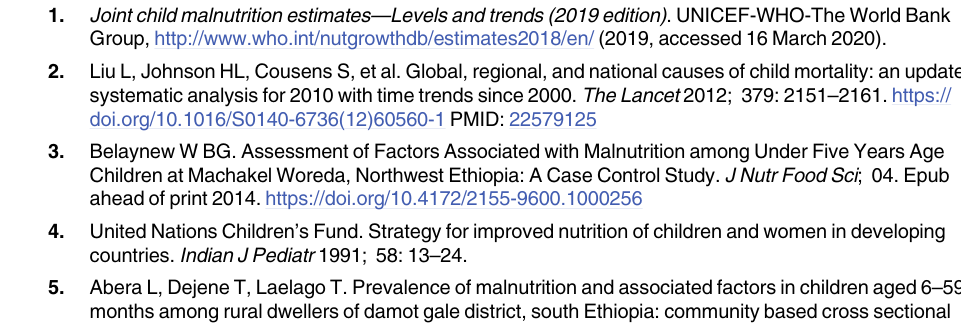
S5 Table. Random effects results from multivariate models. For each indicator, several ran- dom effect mixed models were tested and compared to find the best model according to the AIC criterion. Different random-effect combinations were tested: country alone, cluster alone, cluster and country, and cluster nested in country. For Global Acute Malnutrition and Moder- ate Acute Malnutrition (WHZ, MUAC and indicators combined), the best model was the one with cluster nested in country. For Severe Acute Malnutrition, the best model was the one with cluster alone. Cluster: the smallest geographic units in each country. WHZ: Weight for Height Z-score; MUAC: Mid-upper Arm Circumference. cGAM: combined Global Acute Malnutrition; cMAM: combined Moderate Acute Malnutrition; cSAM: combined Severe Acute Malnutrition. Std. Dev.: Standard deviation. � Conditional modes of the random